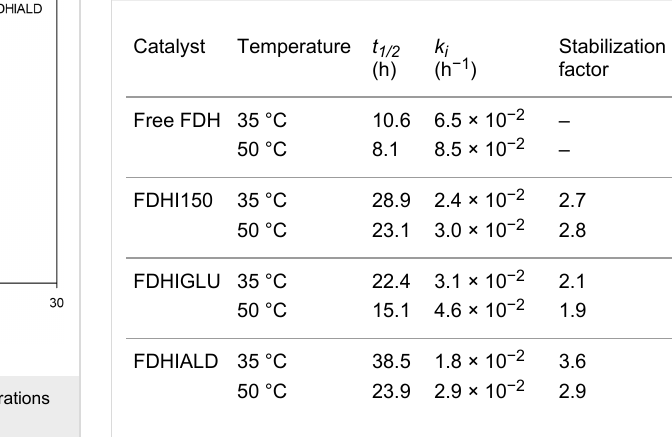
Table 1: The results of thermal stability experiments of free and immo- bilized FDH at 35 and 50